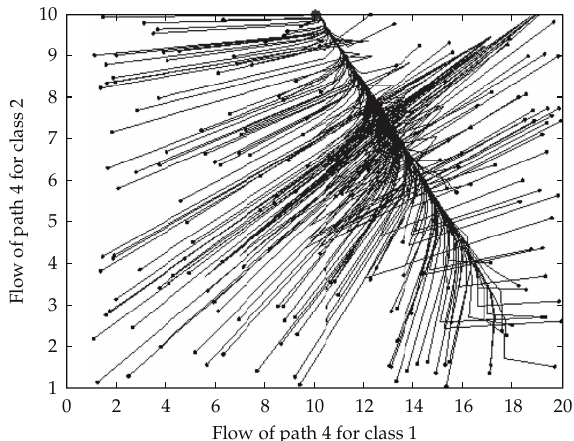
Figure 5: State trajectories demonstrating stability of UE flow on Path